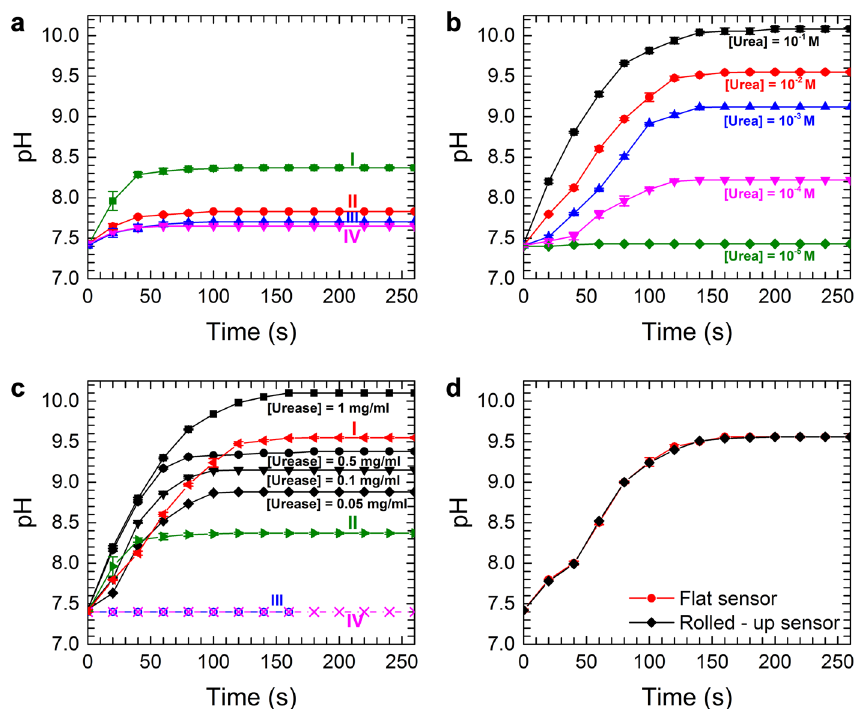
Fig. 5 a Urease activity on (I) the untreated carbon fi lm, (II) coupled to glutaraldehyde; (III) after oxygen plasma treatment and (IV) coupled to glutaraldehyde; [urea] = 10 − 2 M in all cases. b Urea detection using chitosan – urease sensors. The fi lm was exposed to a 1 mg/ml urease solution for immobilization and thoroughly washed before exposure to the urea solutions. c Urease activity in solution (black curves), and (I) the sensor with electrodeposited chitosan and (II) in the presence of the untreated fi lm; (III, IV) control fi lm, untreated with and without electrodeposited chitosan, respectively. Urea concentration is 10 − 2 M in all cases. d Urease activity of fl at and rolled-up sensors; [urea] = 10 − 2 M. All measurements were performed in triplicate, and data points report the mean ± standard